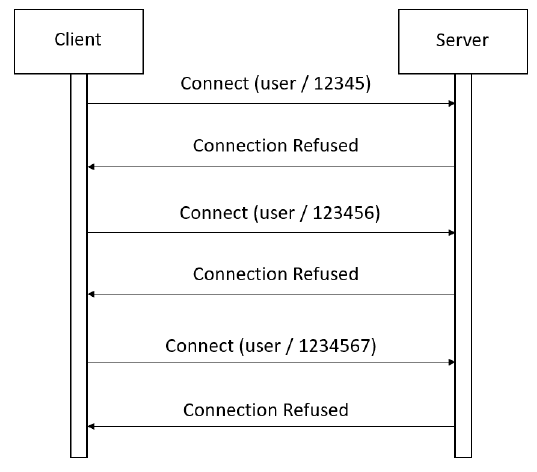
Figure 11. Brute-force